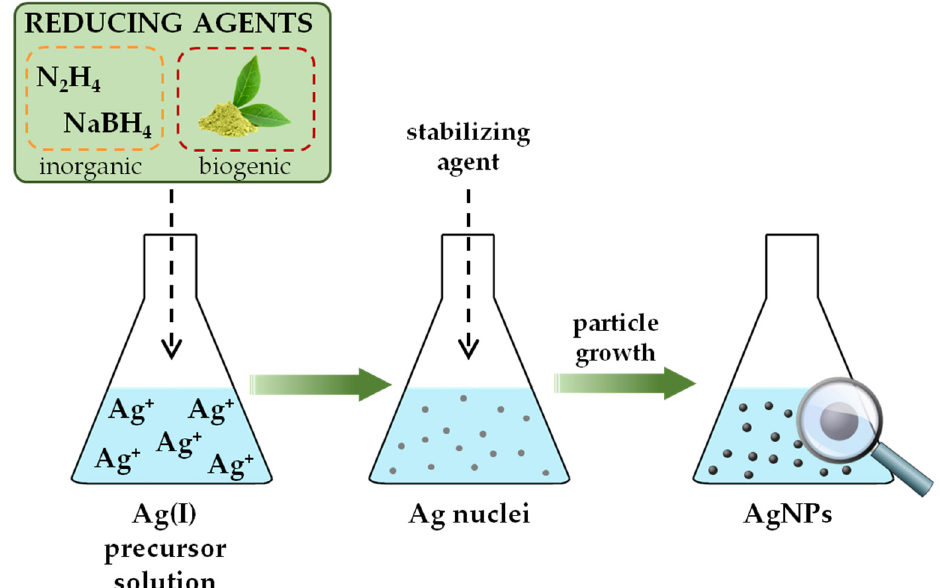
Figure 2. Schematic presentation of AgNP synthesis by reduction in a batch utilizing strong inorganic and mild green reducing agents.